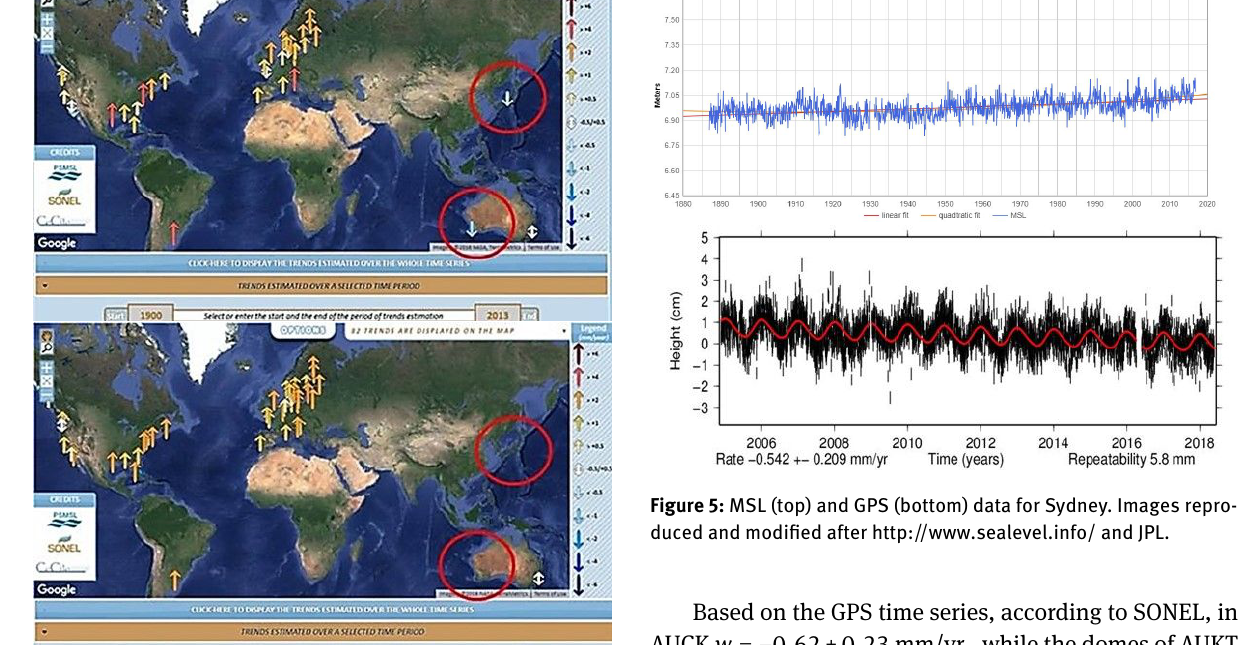
Based on the GPS time series, according to SONEL, in SYDN w = −0.33 ± 0.25 mm/yr.